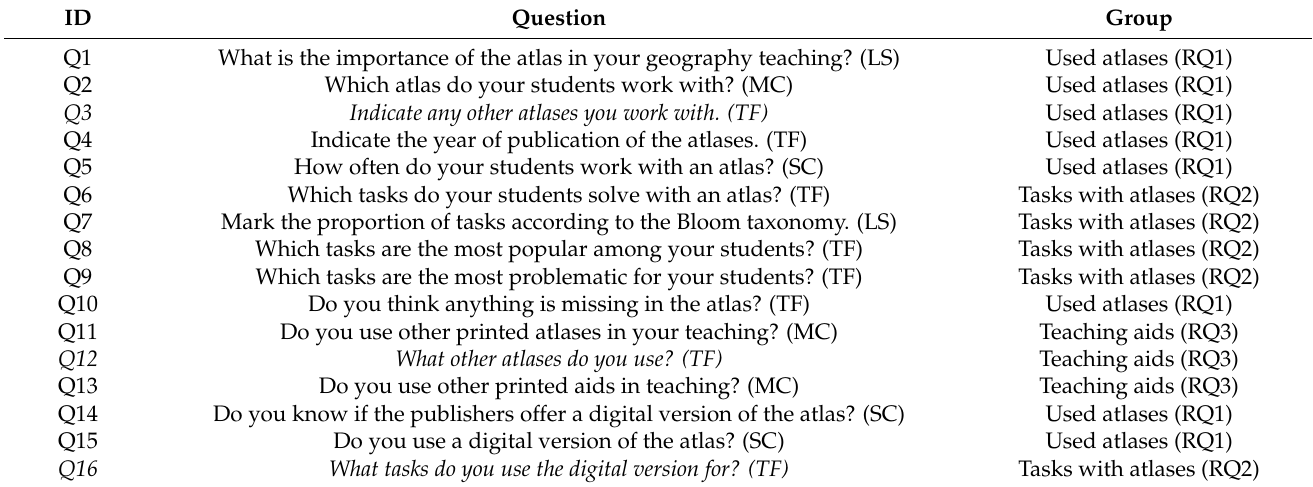
Table 1. List of all survey questions and their classification into